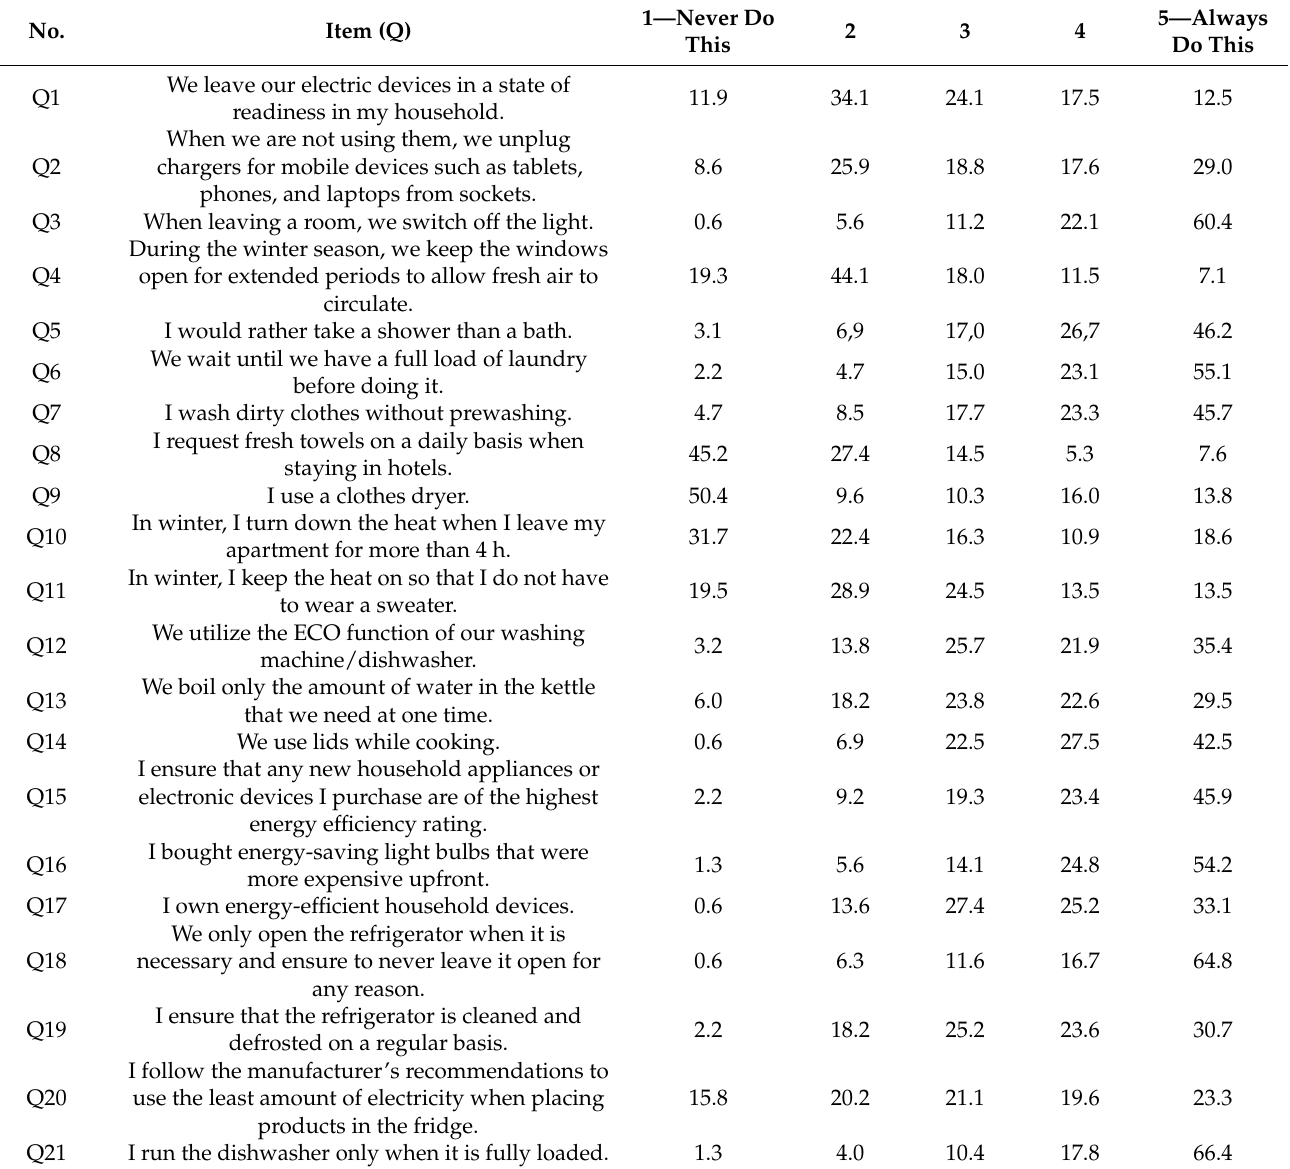
Table 2. Frequency of energy behaviors of prosumers